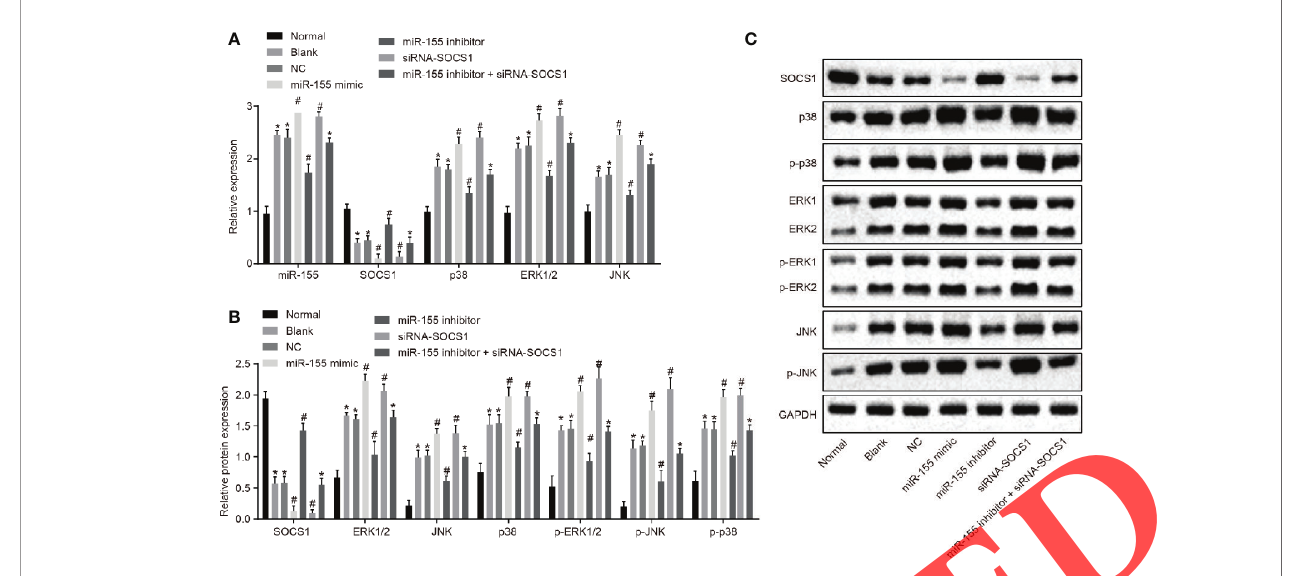
FIGURE 5 | miR-155 activates the MAPK signaling pathway by suppressing SOCS1 expression in hepatic stellate cells. (A) The level of mRNA in related genes. (B) The level of protein in related genes. (C) Western blot protein band diagram. * p < 0.05 vs. hepatic stellate cells of normal rats, # p < 0.05 vs . hepatic stellate cells of rats with AH and hepatic stellate cells transfected with miR-155 NC of rats with AH. The measurement data are expressed as mean ± standard deviation. Data comparisons between groups were performed using one-way ANOVA, with Tukey ’ s post-hoc test for backtesting. Cell experiments were repeated three times. RNA, ribonucleic acid; AH, alcoholic hepatitis; NC, negative cells; ANOVA, analysis of variance.